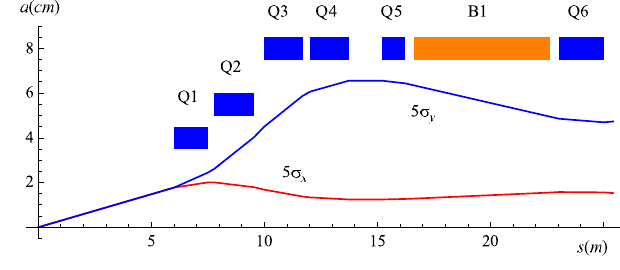
FIG. 3. Beam sizes and aperture of the FF magnets.